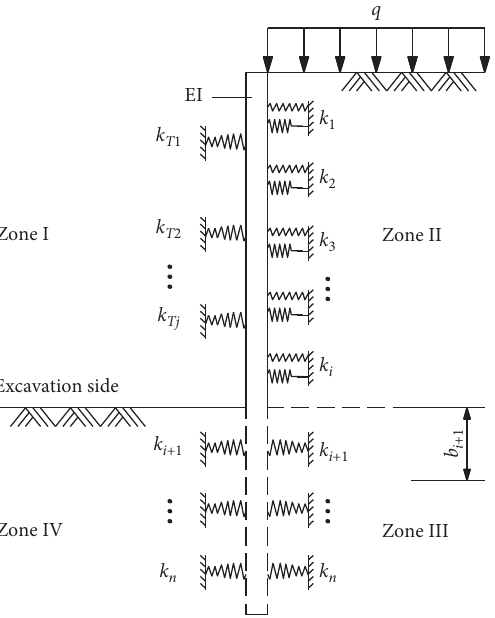
Figure 4: Soil spring equivalent